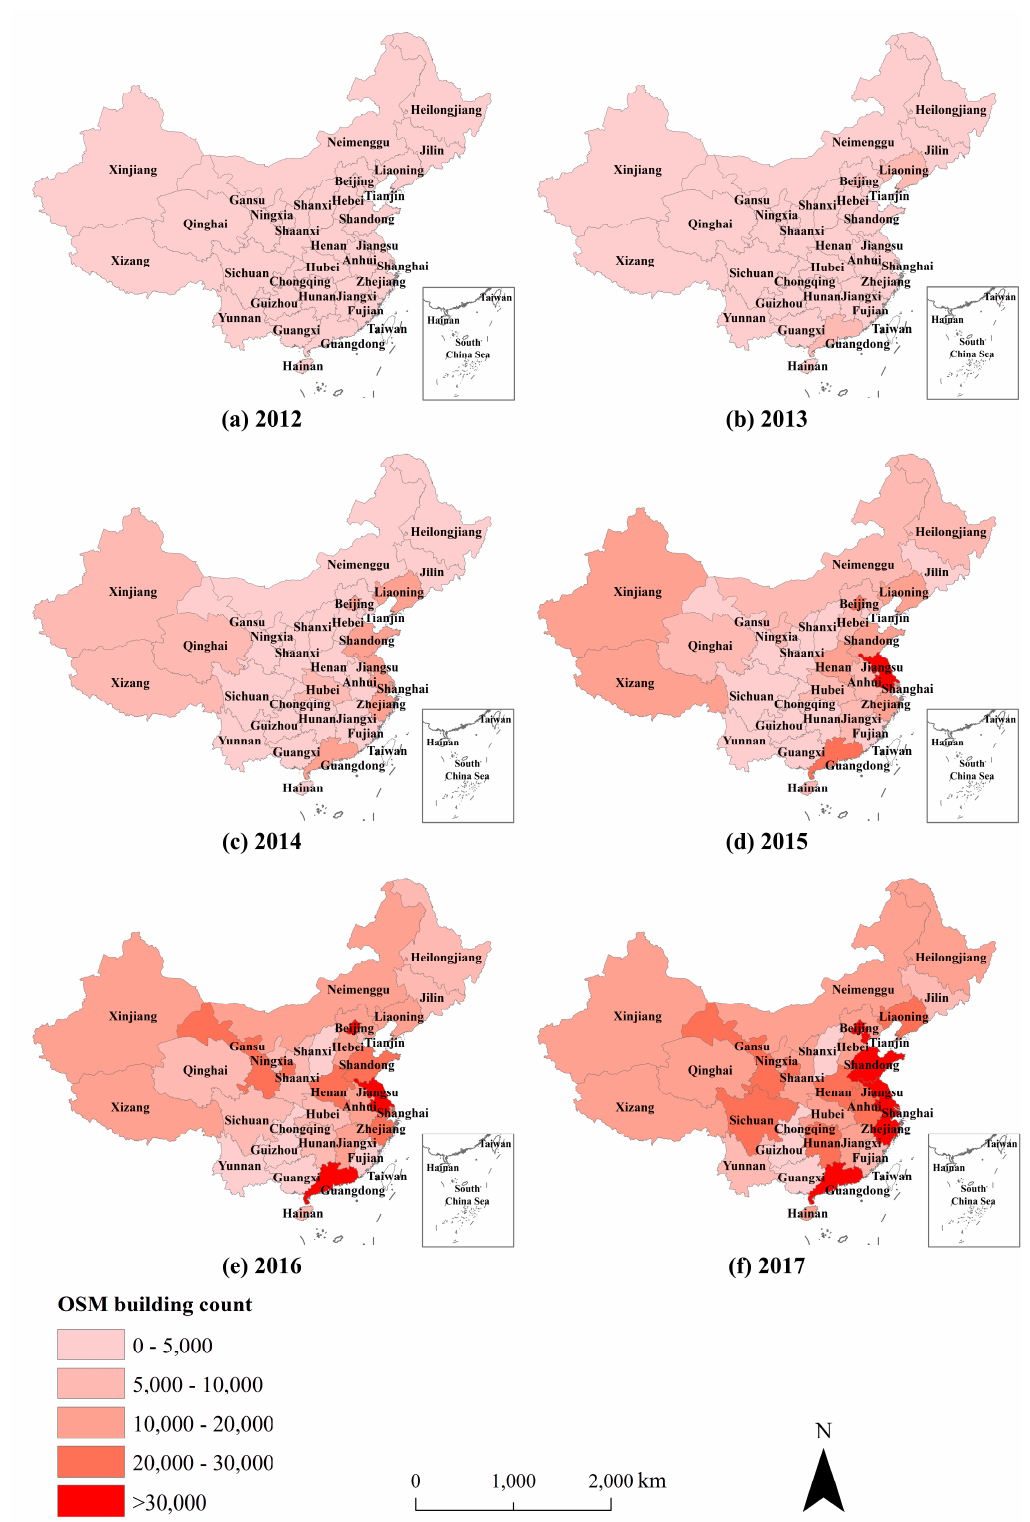
Figure 3. Number distribution of OSM building data for provincial-level divisions in China, from 2012 to 2017 ( a – f ).